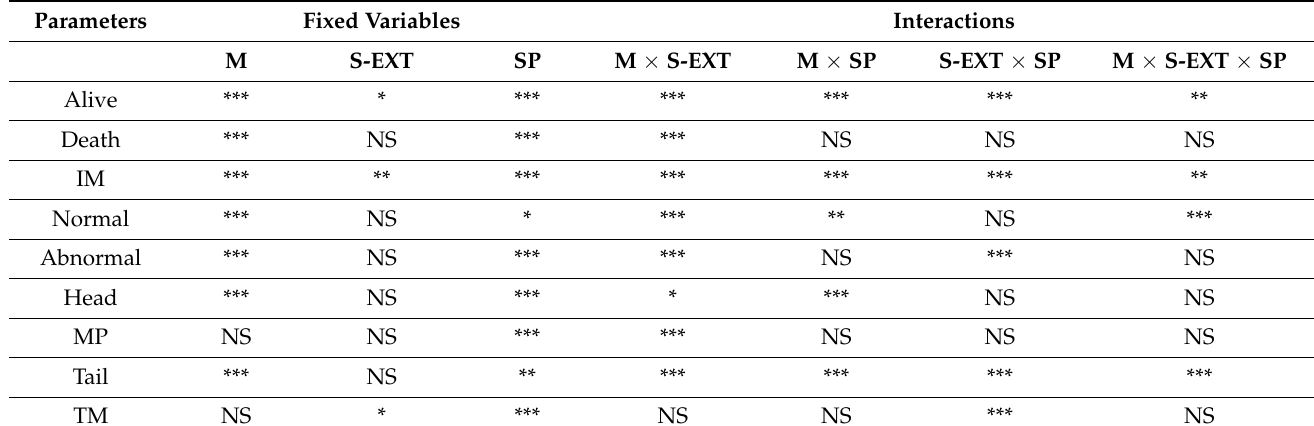
Table 1. Effect of fixed variables (month, semen extender and semen processing) and their one-way and two-way interactions.